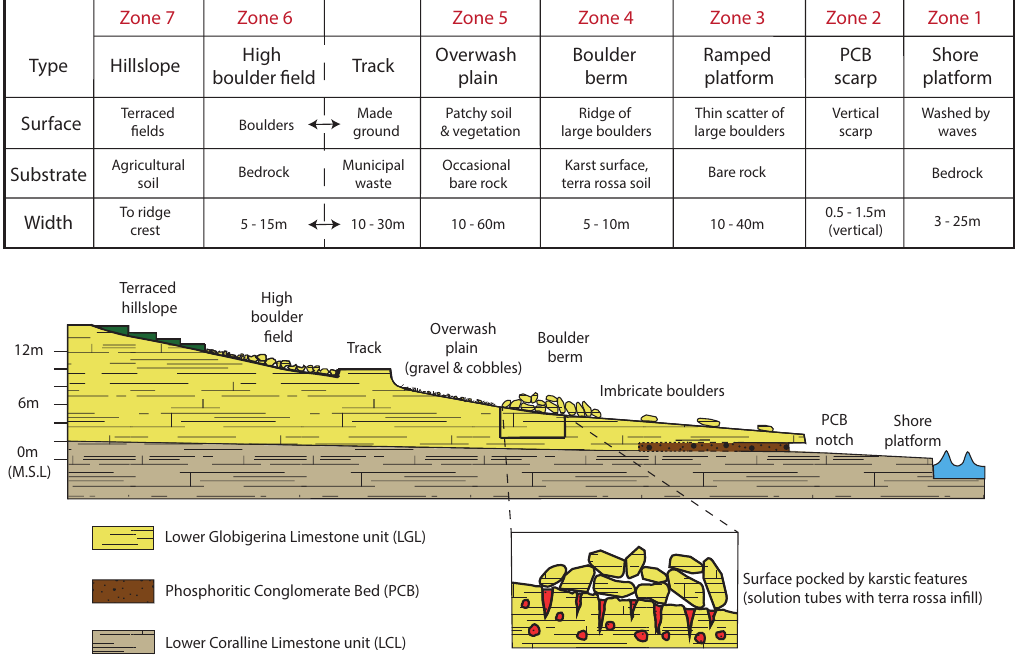
Figure 3. Schematic cross-section and characterisation of the lower coastal slope at the ˙Zonqor study site. Zones 1–7 are referred to in the